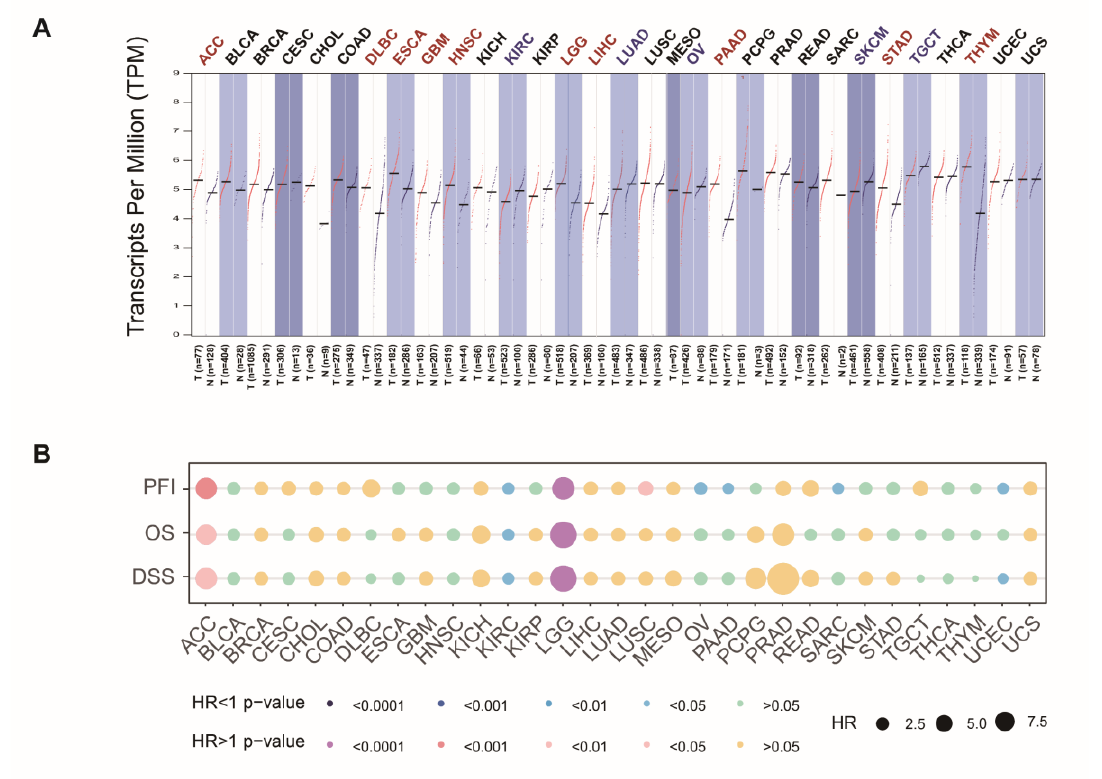
Figure 8. UPF1 pan-cancer analysis ( A ) Expression level of UPF1 in 31 cancer types. ( B ) Disease specific survival (DSS), overall survival (OS), and progression-free interval (PFI) analysis of 31 cancer types based on UPF1 expression.